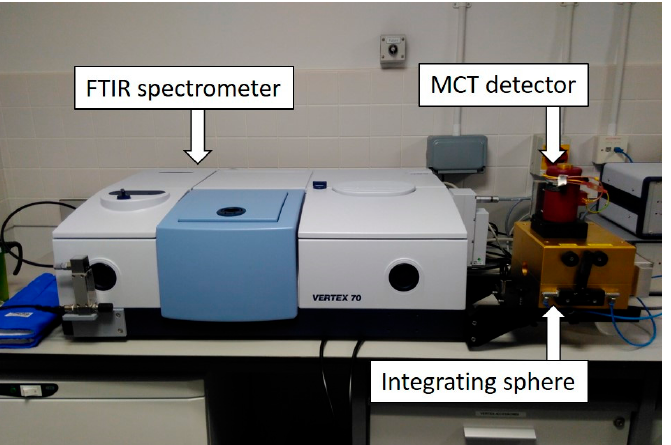
Figure 1. Laboratory setup for surface spectral emissivity determination at King’s College London (KCL), based on a Bruker VERTEX 70 FTIR spectrometer, an external source of high intensity thermal radiation, and a gold-coated integrating sphere with a MCT (mercury-cadmium-telluride) detector cooled with liquid nitrogen.